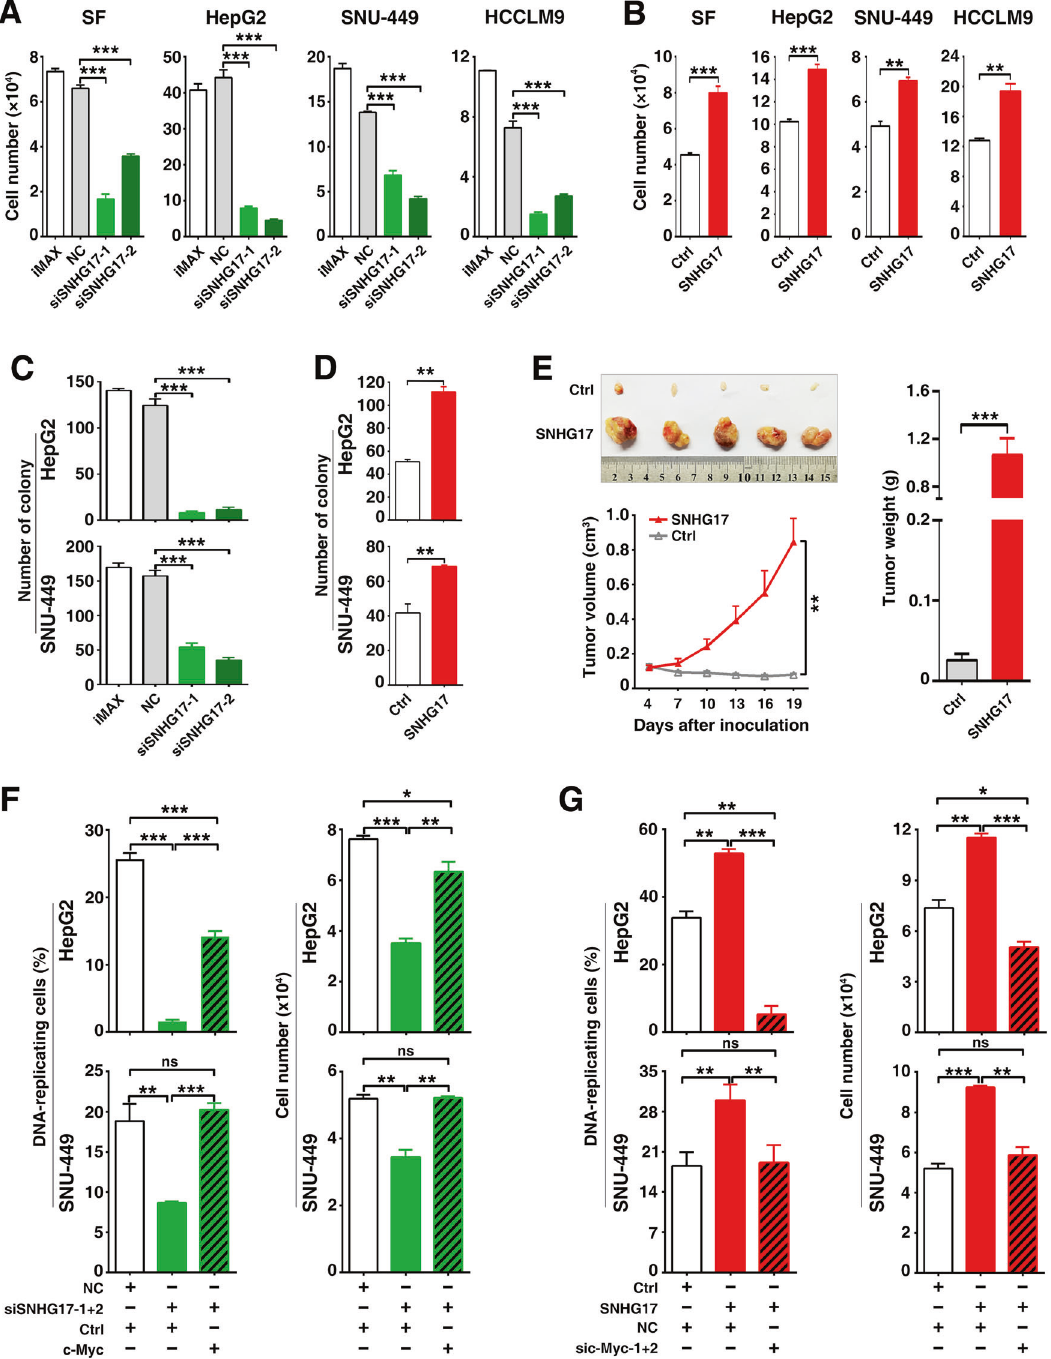
Fig. 4 SNHG17 promotes tumor cell growth via c-Myc. A – B The cell growth was inhibited by silencing SNHG17 but was promoted by overexpressing SNHG17. NC- or siSNHG17-transfectants ( A ) and cells stably expressing SNHG17 and the control cells (Ctrl) ( B ) were subjected to cell counting assays. C – D The colony formation of hepatoma cells was suppressed by silencing SNHG17 but was promoted by overexpressing SNHG17. E The tumor growth was promoted by overexpressing SNHG17 in vivo. HCCLM9 cells stably expressing SNHG17 and the control cells (Ctrl) were subcutaneously injected into NCG mice ( n = 5). F Ectopic expression of c-Myc antagonized the roles of siSNHG17 in decreasing DNA-replicating cells (left panel) and cell growth (right panel). Cells stably expressing c-Myc and the control cells (Ctrl) were co- transfected with the indicated siRNA duplex and then subjected to EdU incorporation assays (left panel) or cell counting (right panel). G Silencing c-Myc abrogated the roles of SNHG17 in increasing DNA-replicating cells (left panel) and cell growth (right panel). Cells stably expressing SNHG17 and the control cells (Ctrl) were co-transfected with the indicated siRNA duplex and then subjected to EdU incorporation assays (left panel) or cell counting (right panel). For A – D and F – G , error bars represent mean ± SEM from three independent experiments. P values were assessed by unpaired Student ’ s t test ( A – D ; E , right; F – G ), or two-way ANOVA ( E , left). * , P < 0.05; ** , P < 0.01; *** , P < 0.001; ns , not signi fi